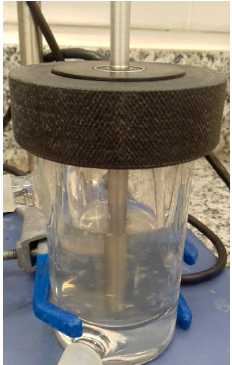
Figure 7. Bench reactor equipped with an impeller without blades used in the production of cyclodextrins from pre-hydrolyzed cassava starch using CGTase CLEA as biocatalyst.